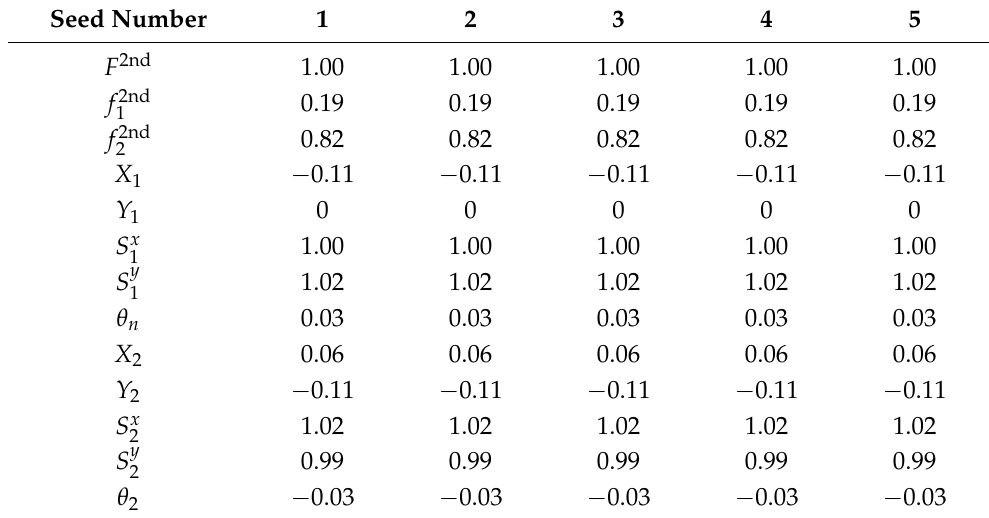
Table 10. Optimization results in second-stage optimization for the six-DoF